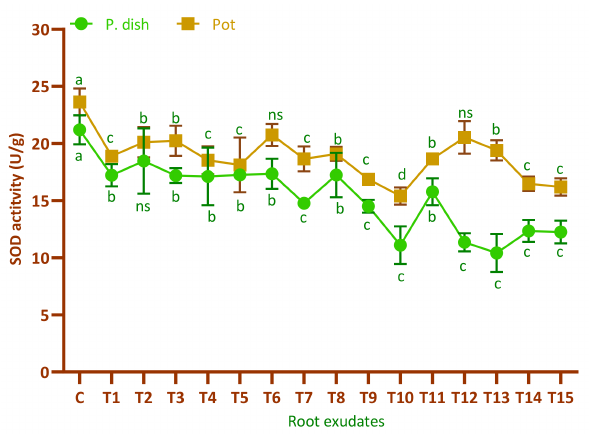
Figure 4. Catalase (CAT) of 10 days old seedlings of T. astivum in Petri dish and pot condition after irrigated with 15 weeds root exudates 1 mL and 5 mL, respectively. Different letters (a, b, and c) indicate significant differences with control at p < 0.05 level. ns = not significant. C = Control, T1: Centella asiatica , T2: Rotala indica , T3: Solanum nigrum , T4: ommelina benghalensis , T5: Marsilea quadri- folia , T6: Ageratum conyzoides , T7: Cynodon dactylon, T8: Spilanthes acmella, T9: Heliotropium indicum, T10: Leucas aspera , T11: Phyllanthus niruri , T12: Sida acuta , T13: Mikania micrantha , T14: Polygonum hydropiper , T15: Physalis heterophylla .